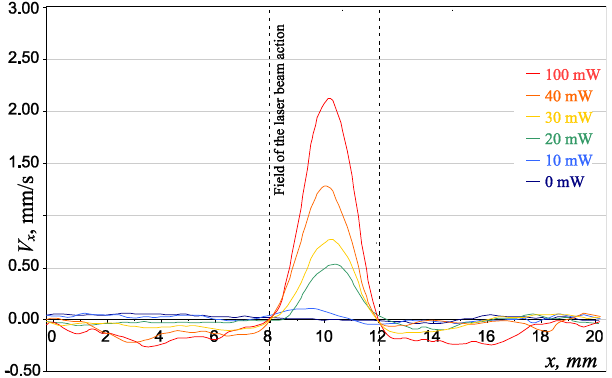
Figure 5. The velocity distribution profile for copper-coated MF particles in a monolayer dust structure under the action of a pushing laser with power values of W = 0, 10, 20, 30, 40, and 100 mW.